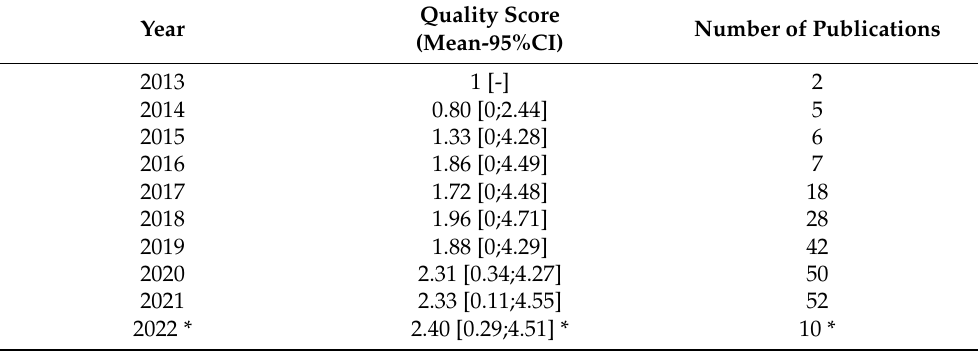
Table 2. Mean quality scores and number of publications per year on PET(/CT)